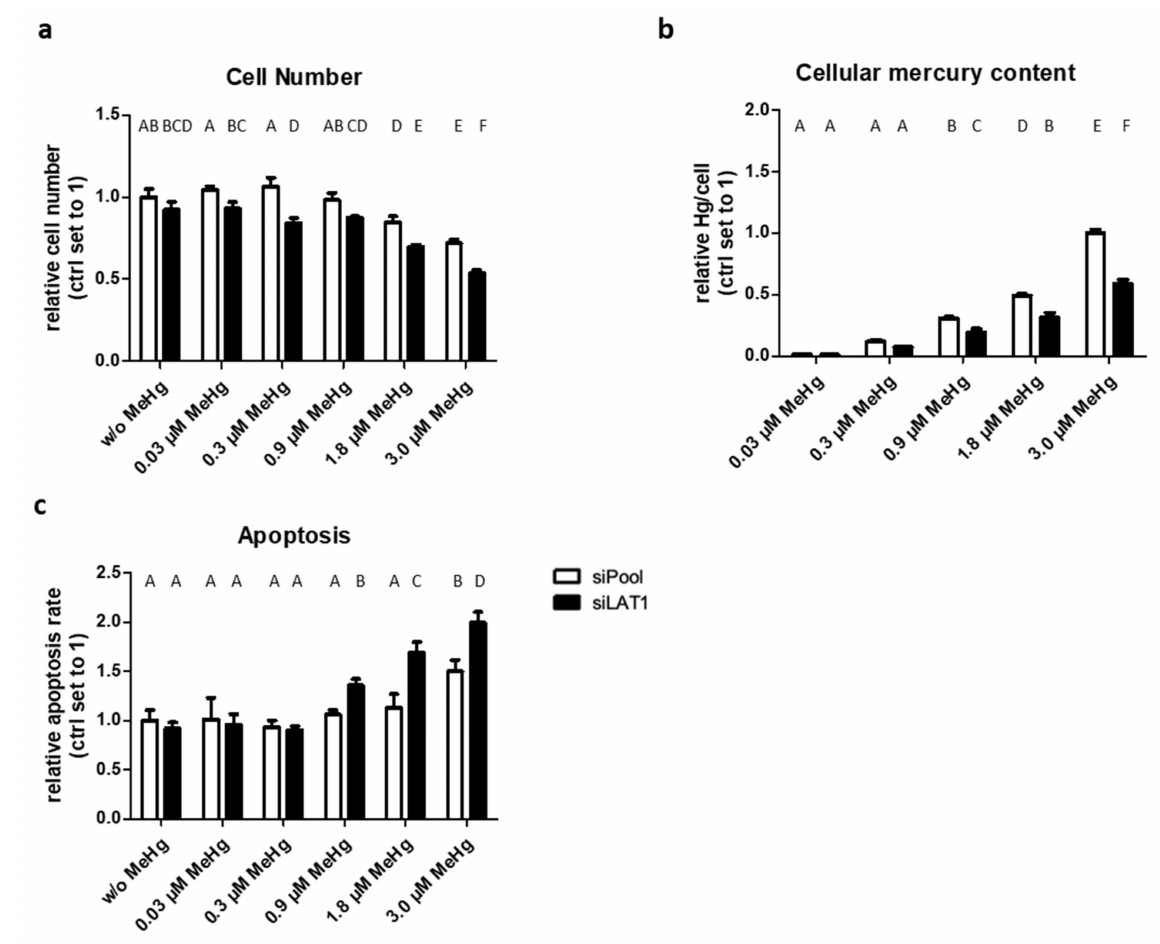
Figure 2. The effect of LAT1 knockdown on cell number, cellular Hg levels, and apoptosis rate in MeHg-exposed HTR8- SVneo cells. Cell number ( a ), cellular Hg content ( b ), as well as apoptosis rate ( c ) in control (siPool) and LAT1-depleted (siLAT1) cells. The data represent mean values ± SD from three independent experiments, each performed in triplicate. Letters A–F denote homogeneous subgroups derived from one-way ANOVA and S–N–K post hoc test ( p < 0.05). Without MeHg treatment, cell viability and cytotoxicity were not affected by